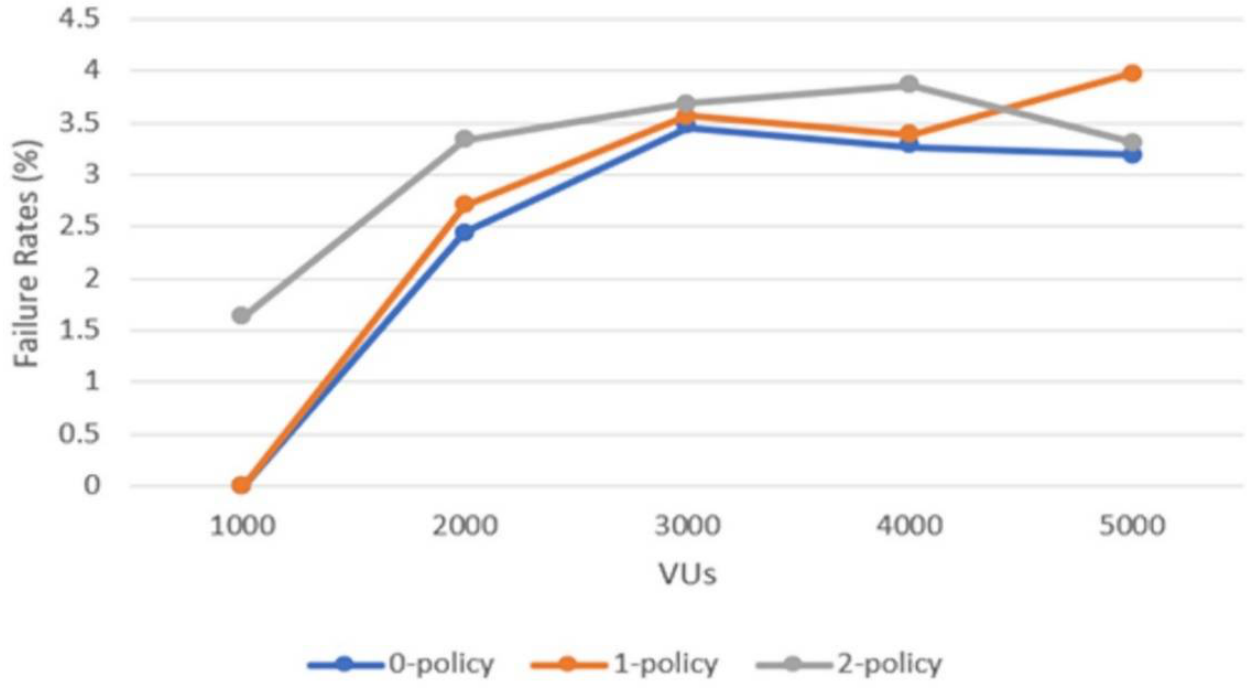
Figure 8. Failure rate versus the number of VUs for the three test cases.